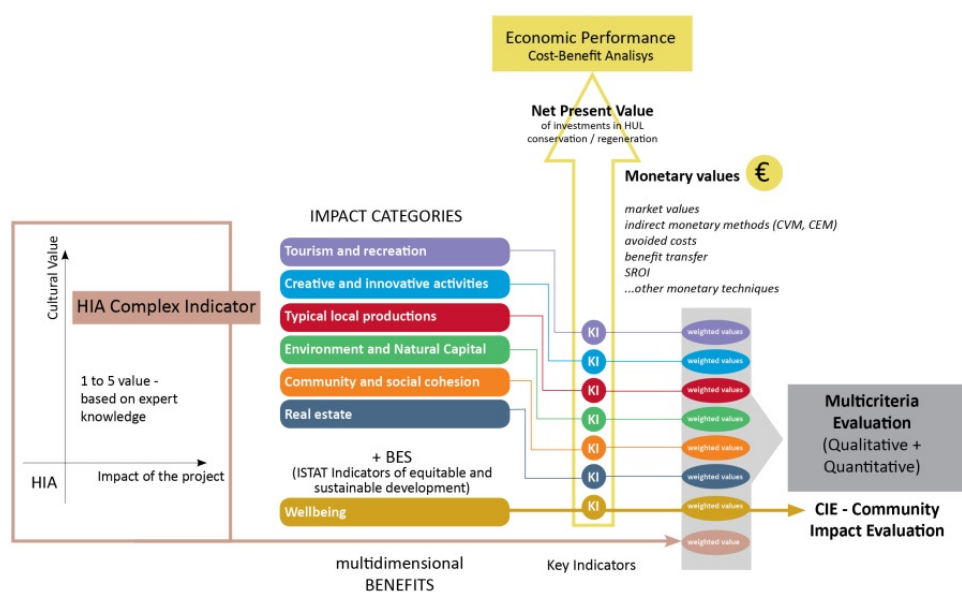
Figure 1: A methodological proposal for the assessing Cultural Urban Landscape